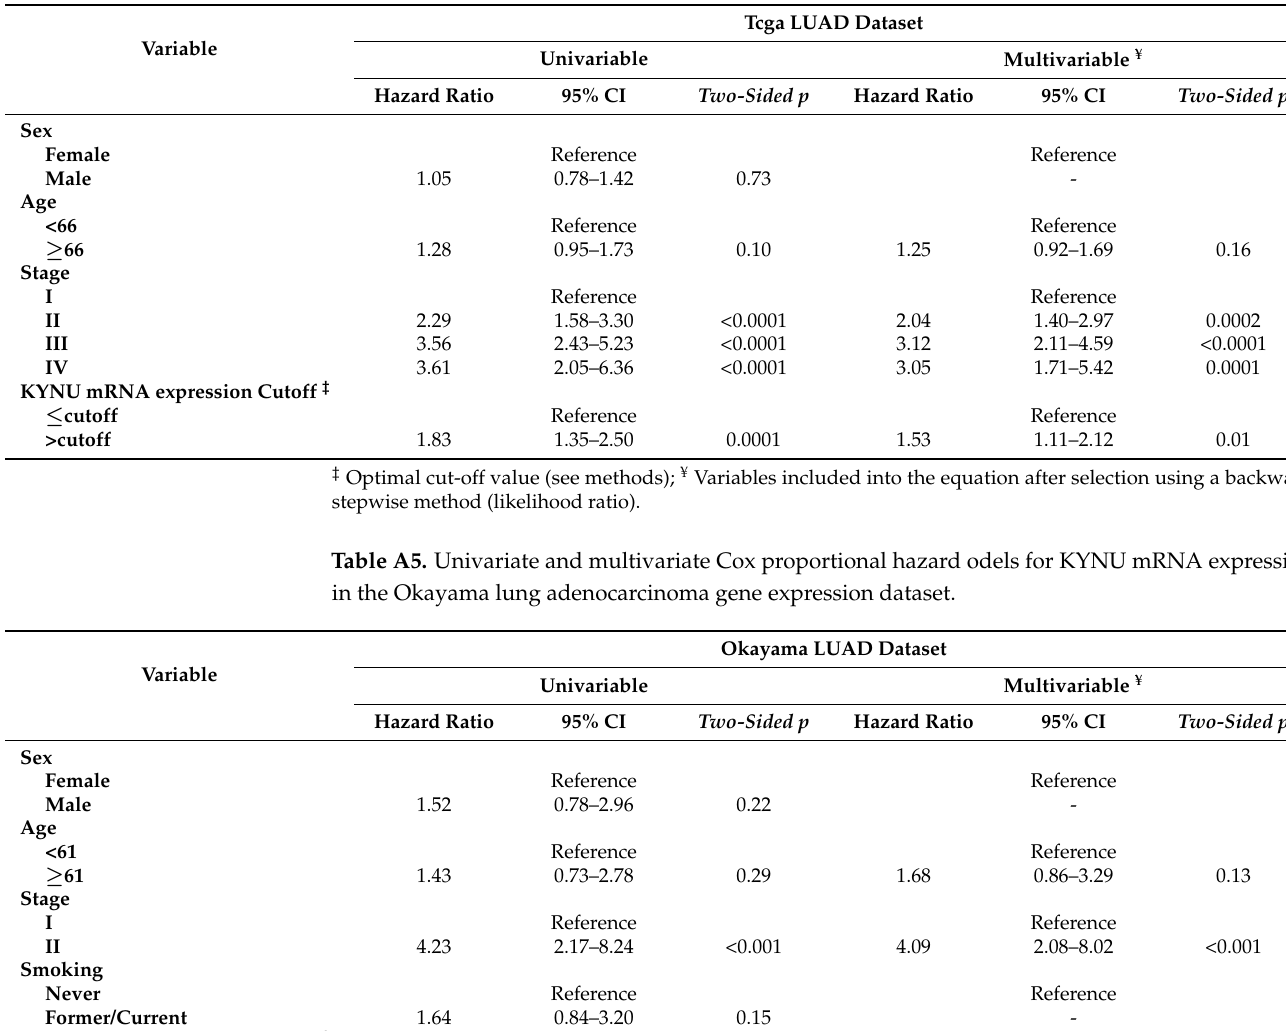
Table A4. Univariate and multivariate Cox proportional hazard models for KYNU mRNA expression in the TCGA-LUAD gene expression dataset.